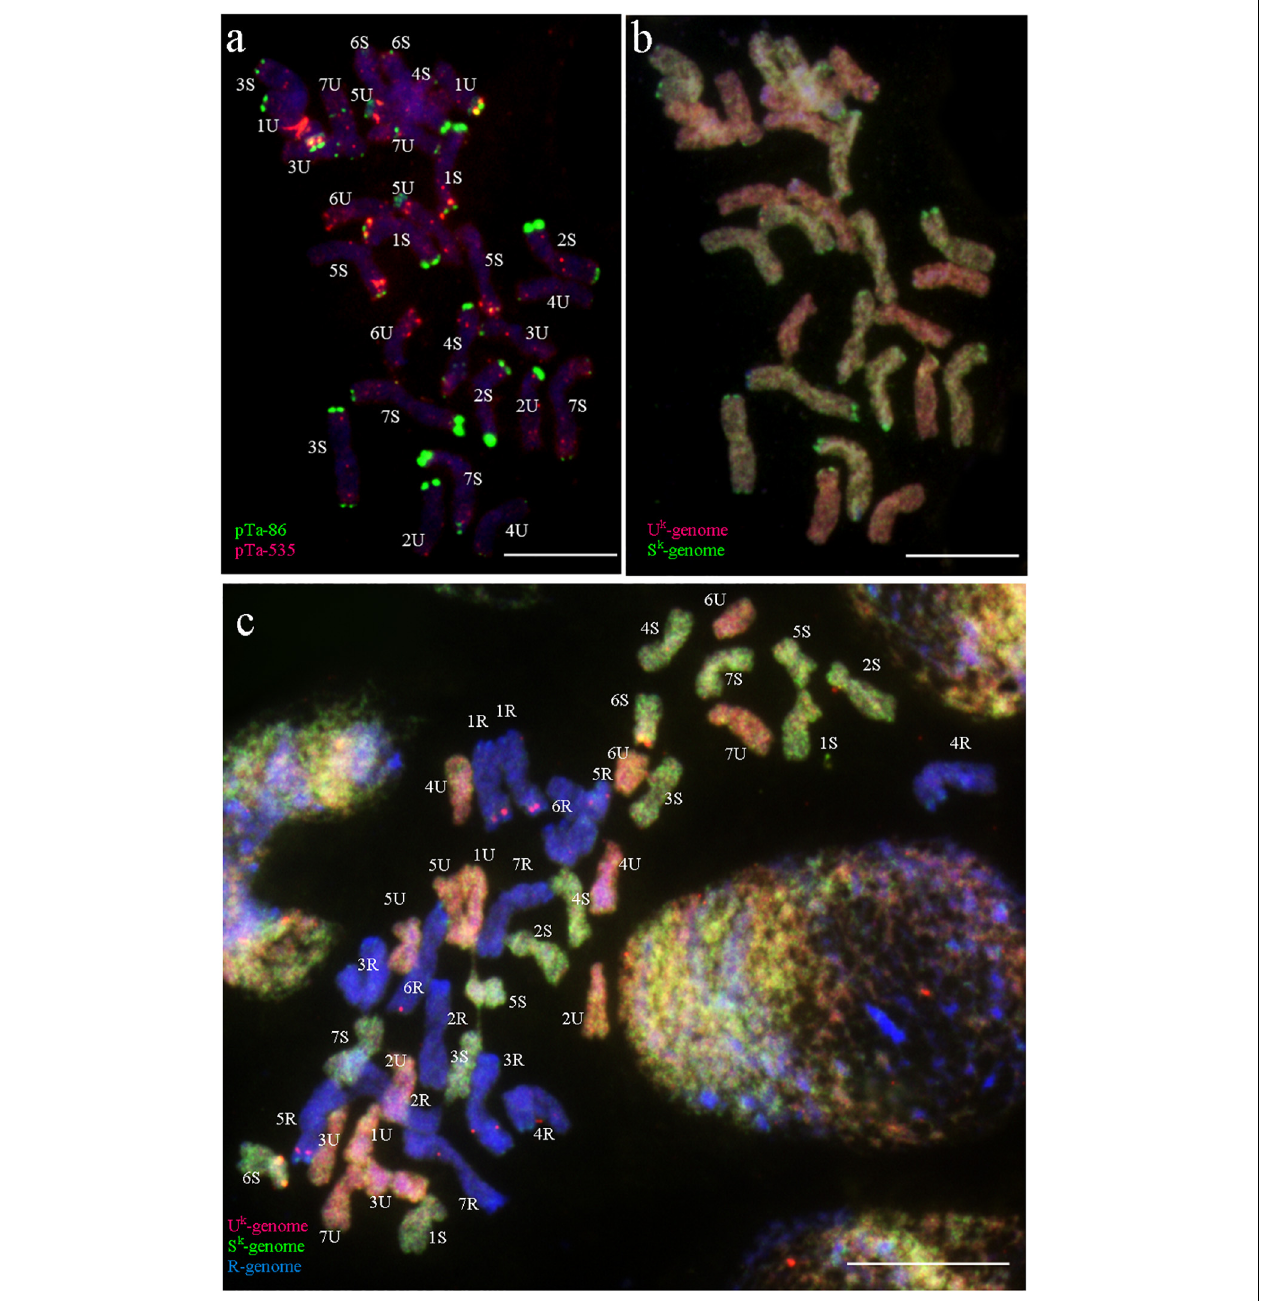
FIGURE 2 | Fluorescence/genomic in situ hybridization performed on mitotic chromosomes of A. kotschyi Boiss (2 n = 6 x = 42; U k U k S k S k ; no. 14808 using (a) pTa-86 (Atto-488, green), pTa-535 (Atto-550, red). Genomic in situ hybridization using U-genome (Atto-550, red) and S-genome (Atto-488, green) probes performed on mitotic chromosomes of (b) A. kotschyi and (c) Aegilops kotschyi × Secale cereale (2 n = 6 x = 42; UUMMRR). (a,c) Chromosomes counterstained with DAPI (blue). Scale bar, 10 µ